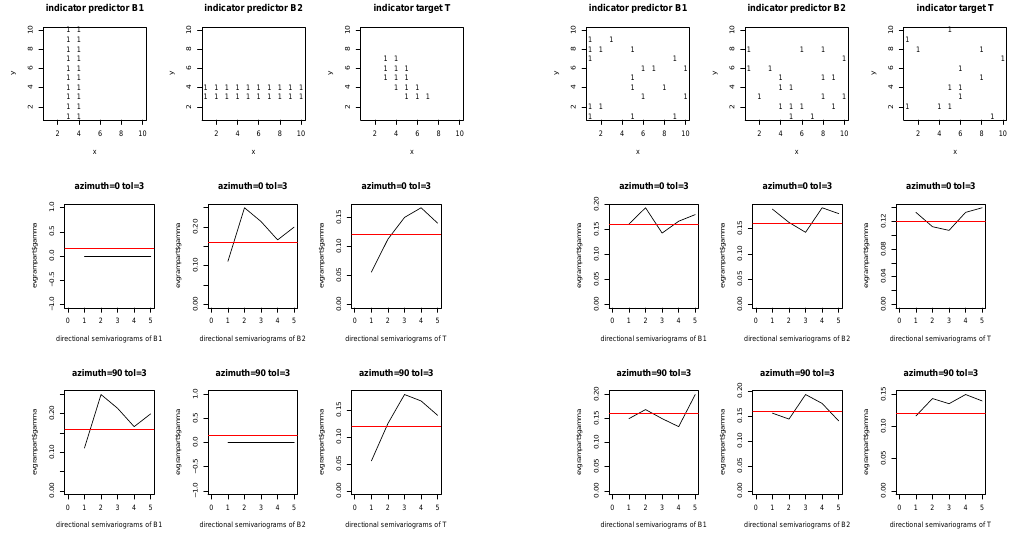
Figure 1. Spatial distribution of two indicator predictor variables B target variable T of the dataset RANKIT and two uni-directional semi-variograms ( left ); and the spatial distribution of two indicator predictor variables B variable T of the dataset RANKITMIX and two uni-directional semi-variograms ( right ), revealing different spatial distributions and different geostatistical characteristics than RANKIT . The red lines indicate the values of the classical sample variances.